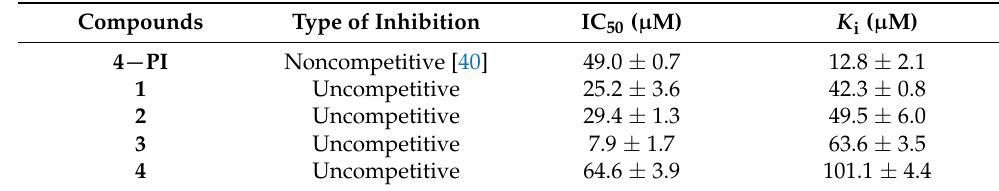
Figure 6. The characterization of spiro-oxindole skeleton compounds as potent IDO1 inhibitors. Kinetic parameters of the four compounds were determined according to the plots of [S]/[V] against compound concentrations [I]. The L-Trp concentrations varied from 50 to 150 µ M. The intersection points in plots are used to determine the K i values. The K i values are presented as the mean ± SD with three independent determinations. Table 1. Inhibitory activity of spiro-oxindole skeleton compounds against IDO1 and determination of inhibition types a